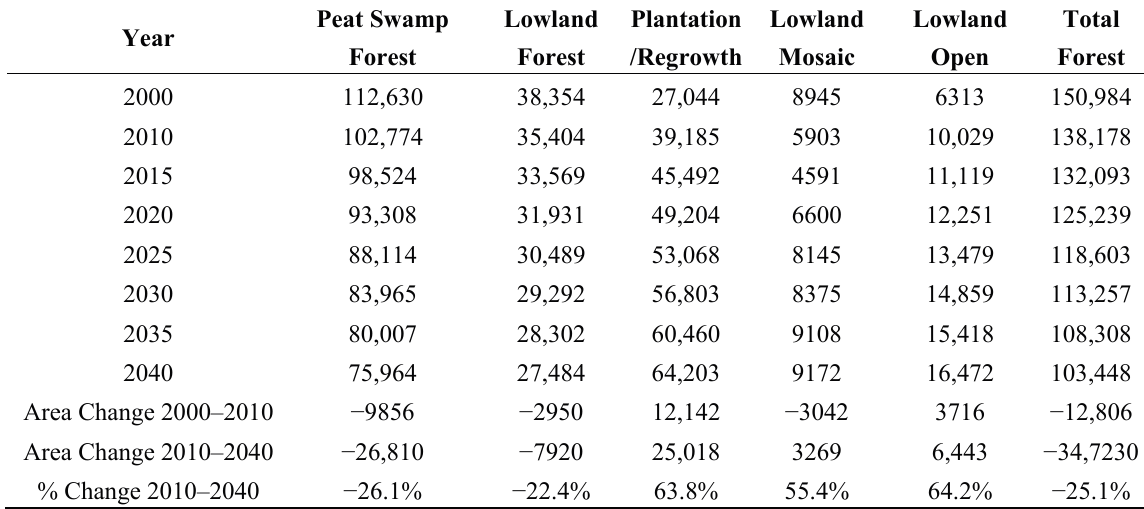
Table 5. Land Cover Change (ha) in Protected Areas. (Category Mangrove is not present in Protected Forest areas.)